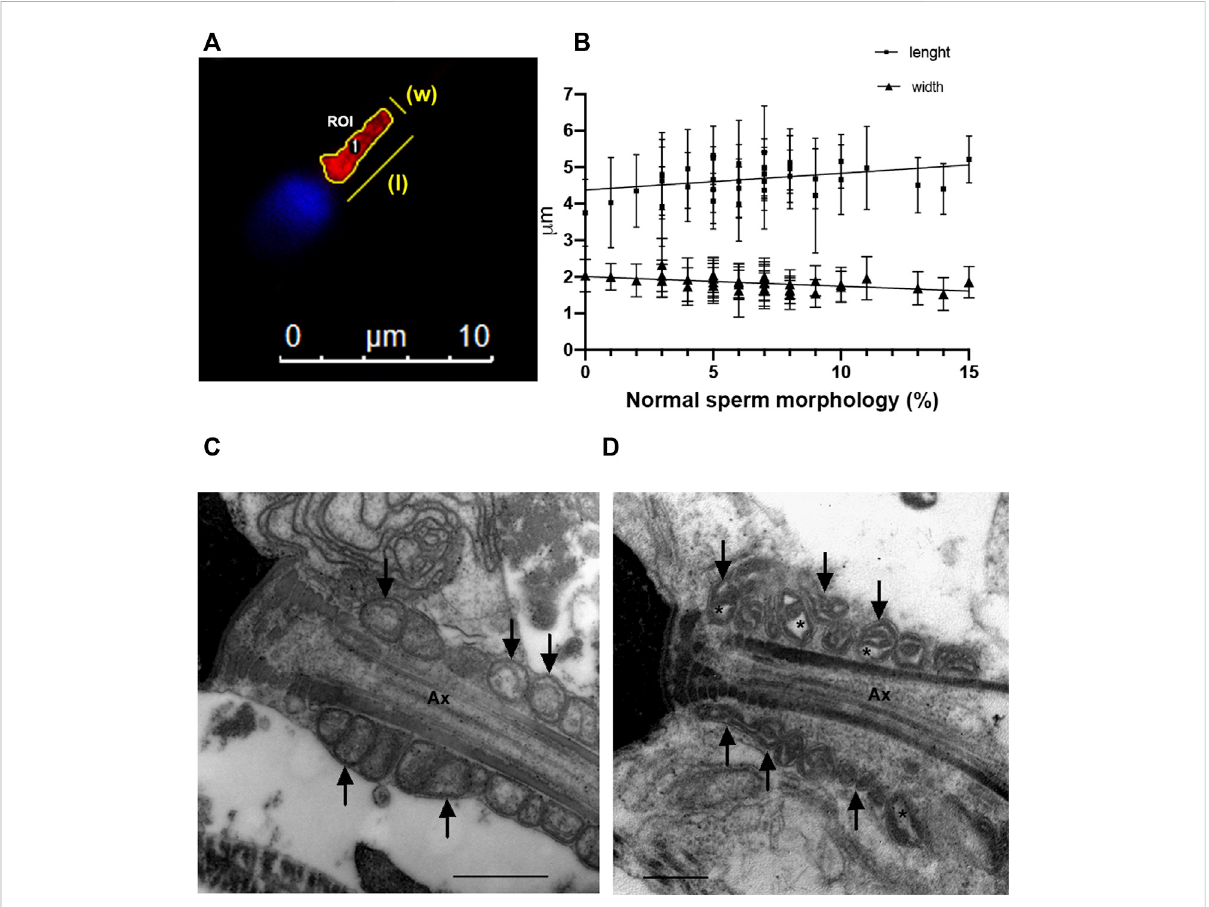
FIGURE 2 Sperm morphology analysis (A) Epi fl uorescence microscopy of the mid-piece of a human sperm cell. Manual segmentation of sperm mid- pieces using ImageJ/FIJI; (B) Correlation between mid-piece length and width and normal sperm morphology ( N = 36). (C) Electron microscopy of sperm from a normozoospermic fertile man. (D) Electron microscopy of sperm from an infertile man with abnormal semen parameters. Defects on mitochondria are shown with arrows and asterisks indicate alterations in mitochondrial membranes. Ax = axoneme. Bars: 500